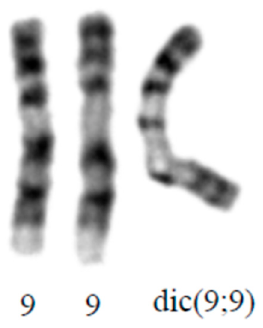
Figure 3. Partial karyogram of cultured lymphocytes from peripheral blood of patients showing dic(9;9)(q21.1;q21.1).